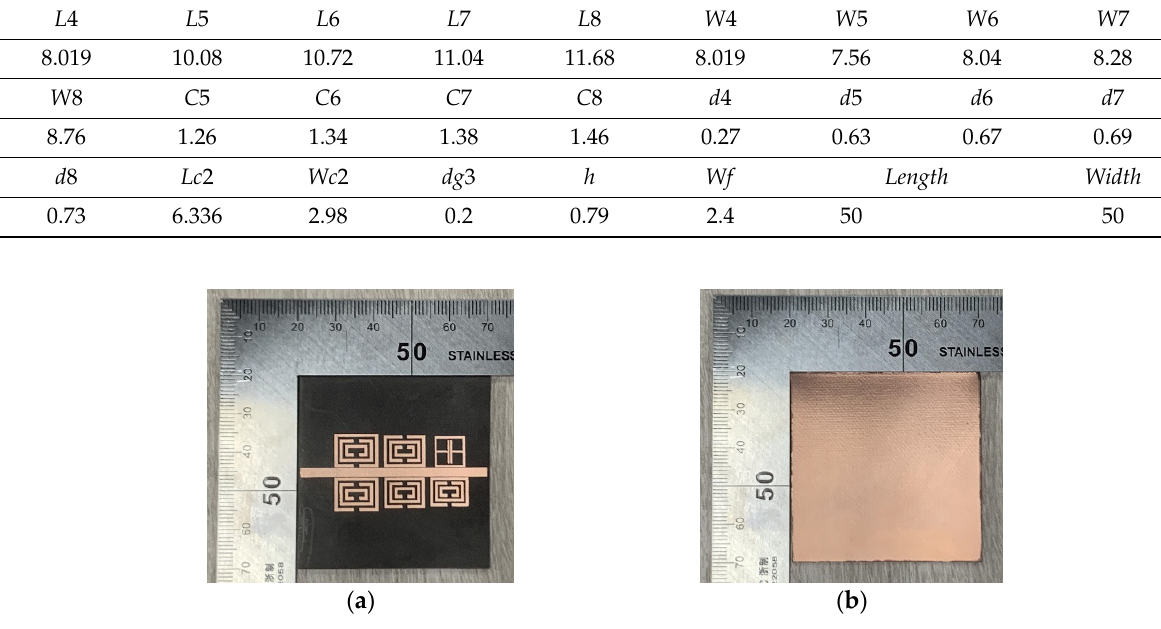
Figure 7. The 6-bit chipless RFID tag simulation and measurement of S21 response curve. Table 2. The 6-bit chipless RFID tag design size value (unit: mm).